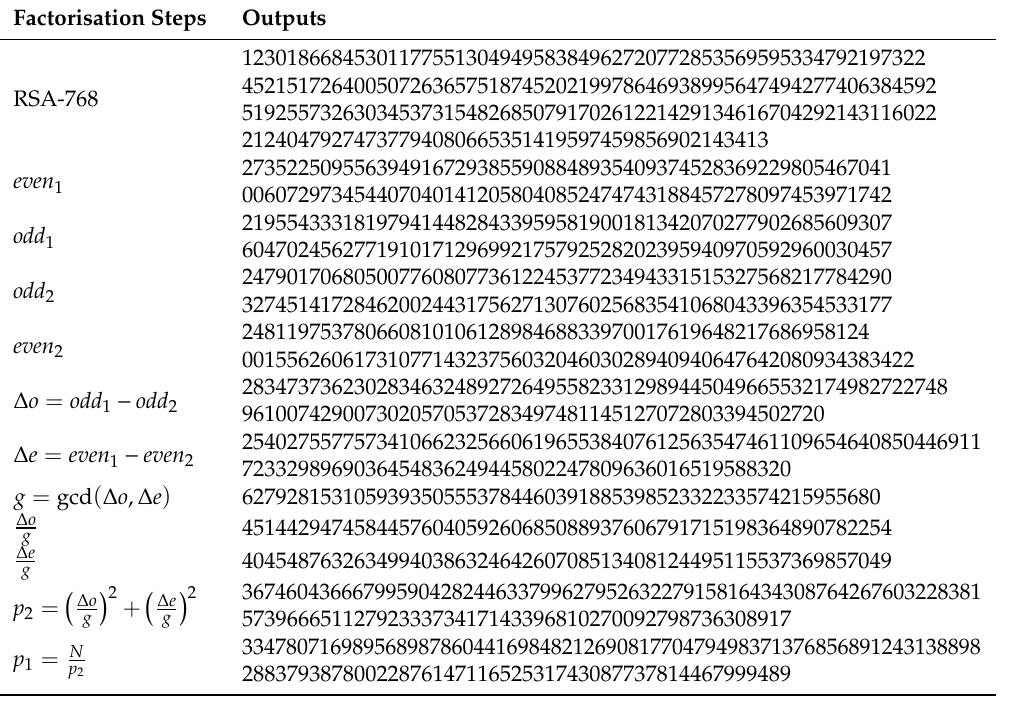
Table 3. Rivest–Shamir–Adleman (RSA) factorisation (e.g. RSA-768) using the proposed